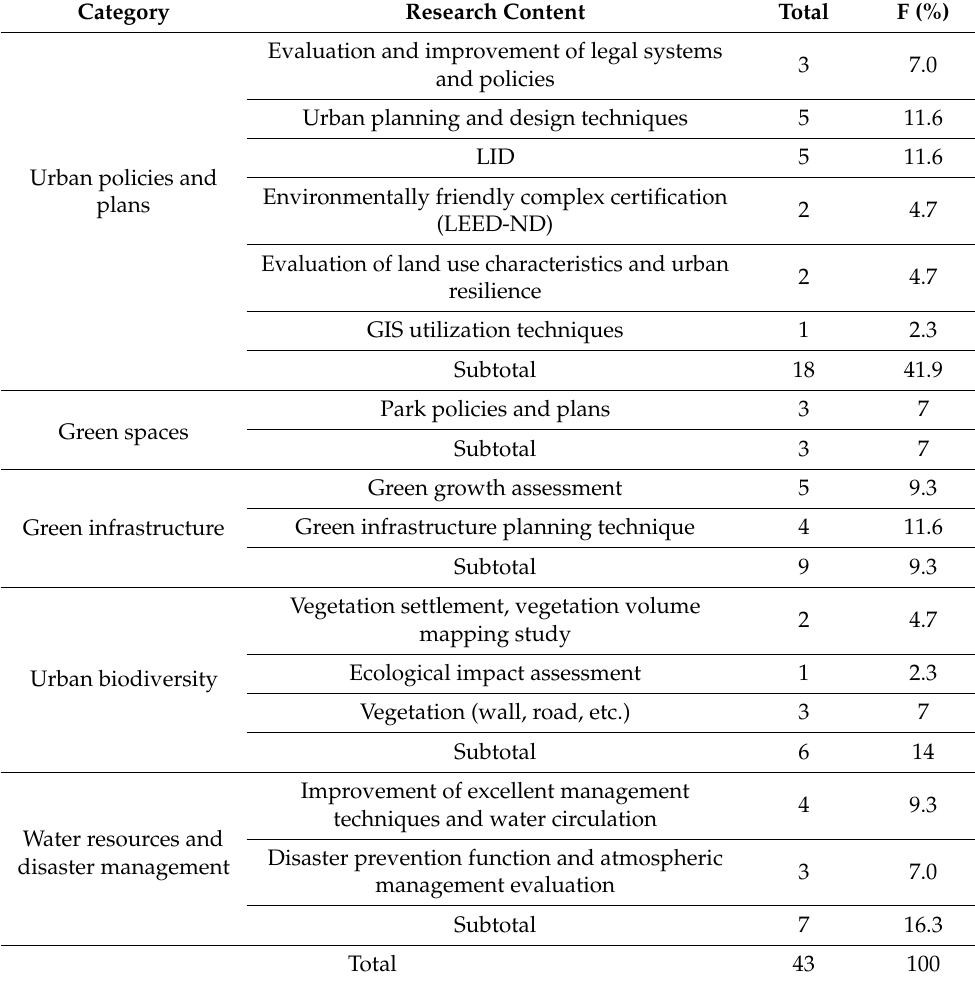
Table 6. Domestic green infrastructure research content in South Korea.